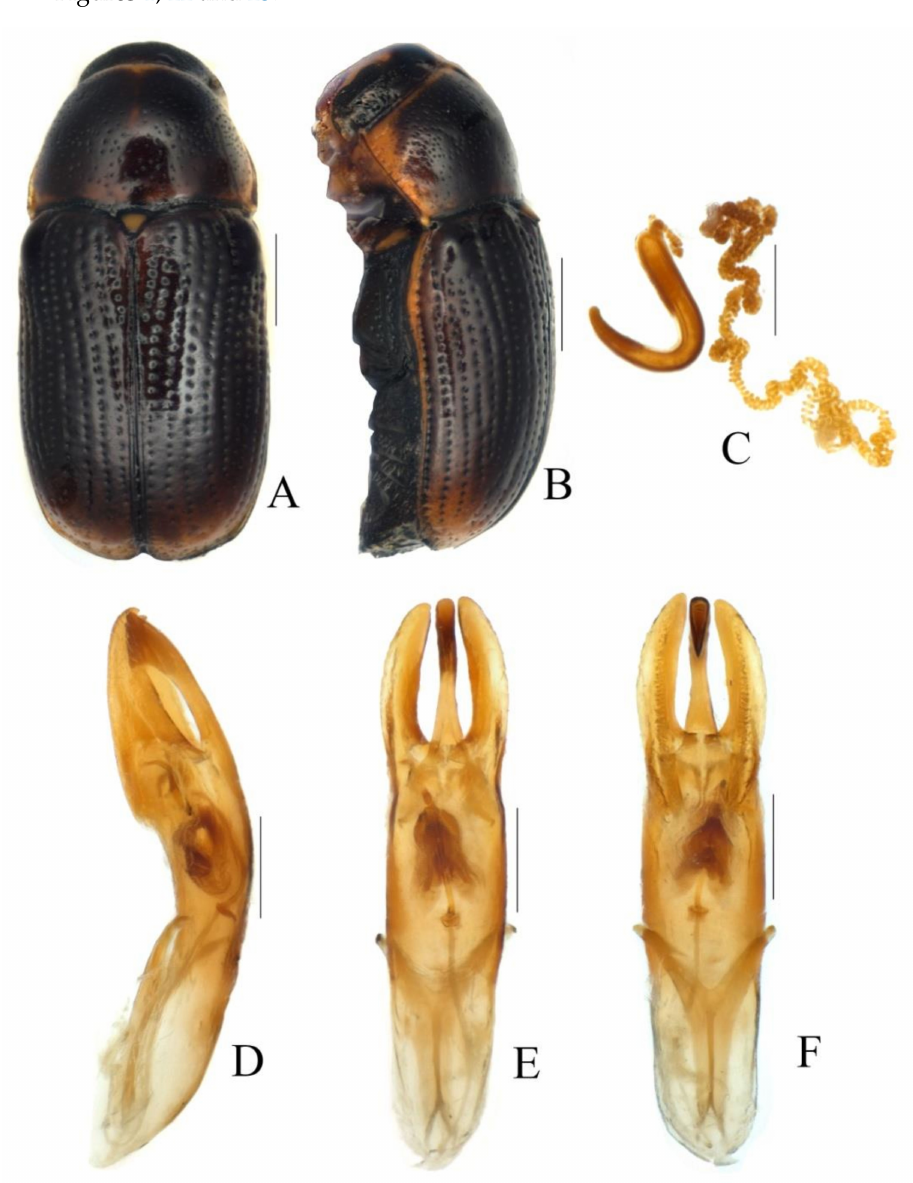
Figure 22. Cryptocephalus ( Burlinius ) nebulo Weise, 1889: ( A ) habitus; ( B ) lateral view of habitus; ( C ) spermatheca; ( D ) lateral view of aedeagus; ( E ) dorsal view of aedeagus; ( F ) ventral view of aedea- gus (Scale bars: ( A , B ) = 0.5 mm, ( C – F ) = 0.2 mm) (( A , B , D – F ): male; ( C ): female; both from